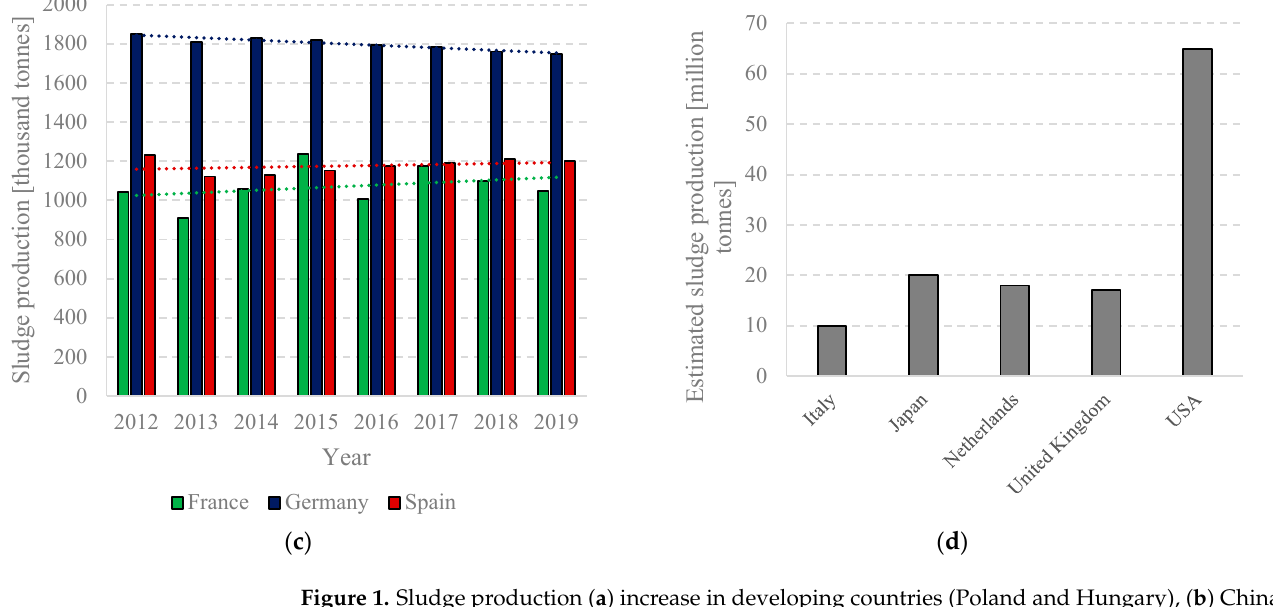
Figure 1. Sludge production ( a ) increase in developing countries (Poland and Hungary), ( b ) China; ( c ) in developed countries (France, Germany and Spain); and ( d ) in selected countries.